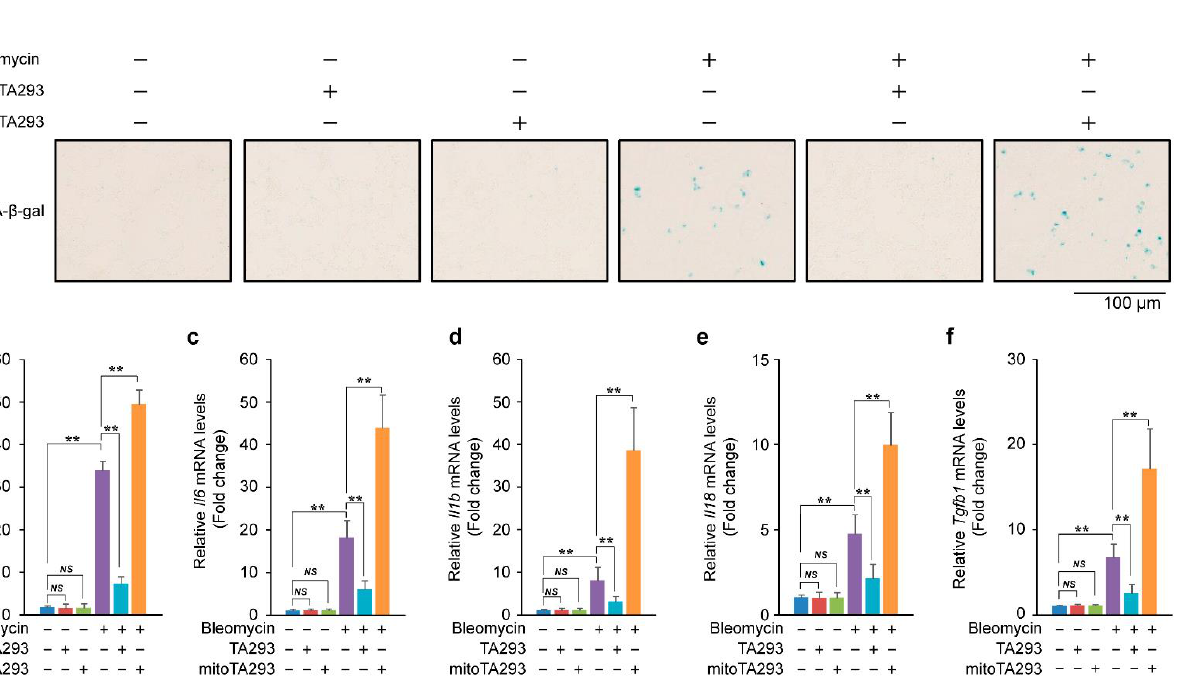
Figure 2. Effects of TA293 and mitoTA293 on cellular senescence in BLM-induced pulmonary fibrosis model mice. ( a ) Detection and ( b ) quantification of cellular senescence by SA- β -gal staining. Expression of the senescent cells secrete senescence-associated secretory phenotype (SASP) factors ( c ) Il6 , ( d ) Il1b , ( e ) Il18 , and ( f ) Tgfb1 mRNA. The data are presented as the mean ± SEM ( n = 5 per group); ** p < 0.01; NS , not significant.